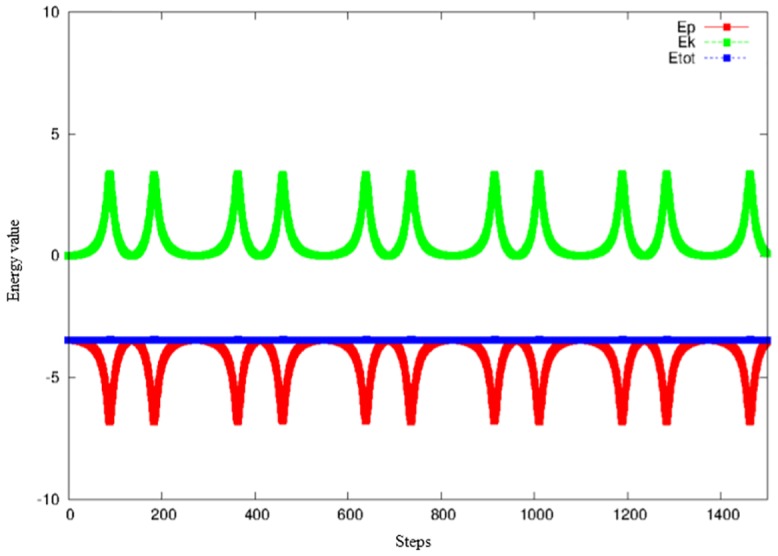
Energy conservation for μ = 0, Δt = 0.005.